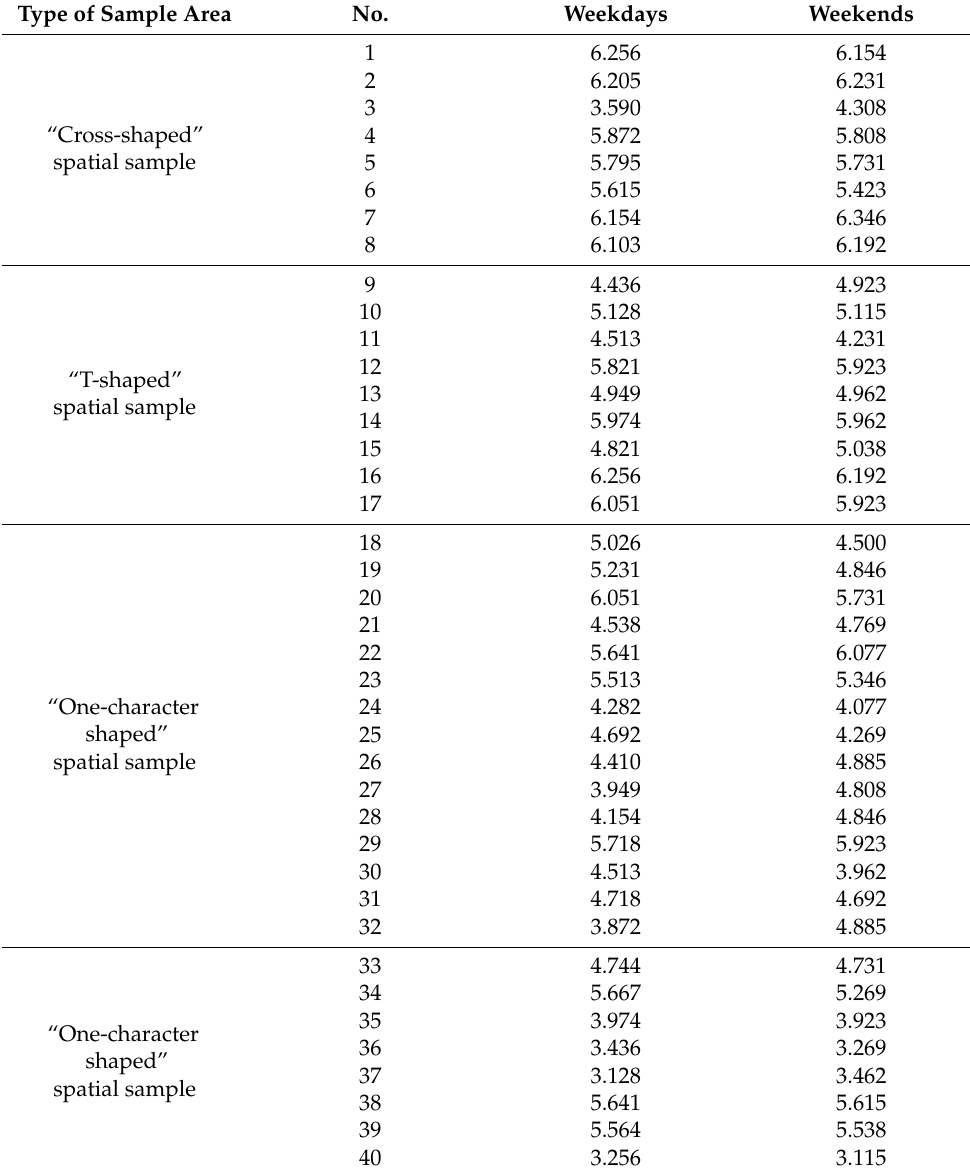
Table 4. The heat value of tourist flow in different types of sample areas on weekdays and weekends. Type of Sample Area